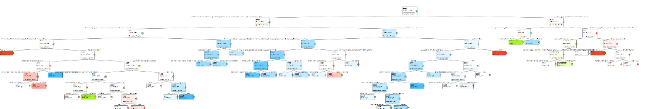
Fig. B1. Classification Tree with pre-university grades